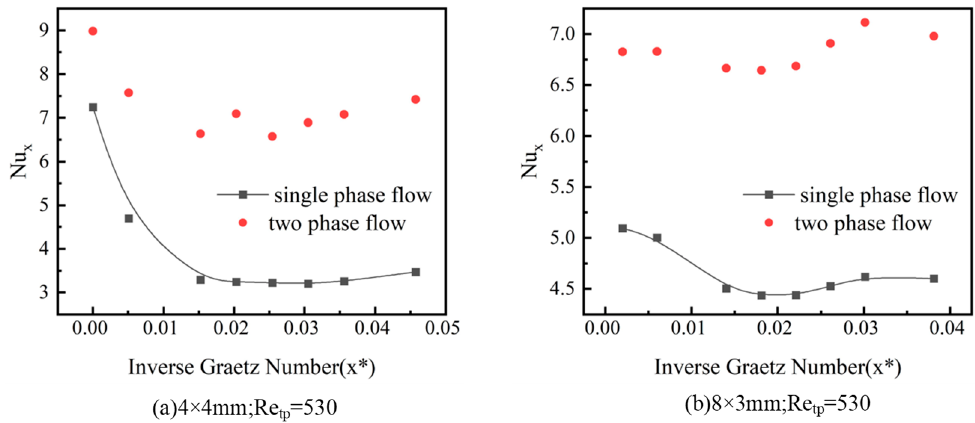
Figure 9. Single-phase and two-phase local Nusselt numbers of square and rectangular cross-section channels.